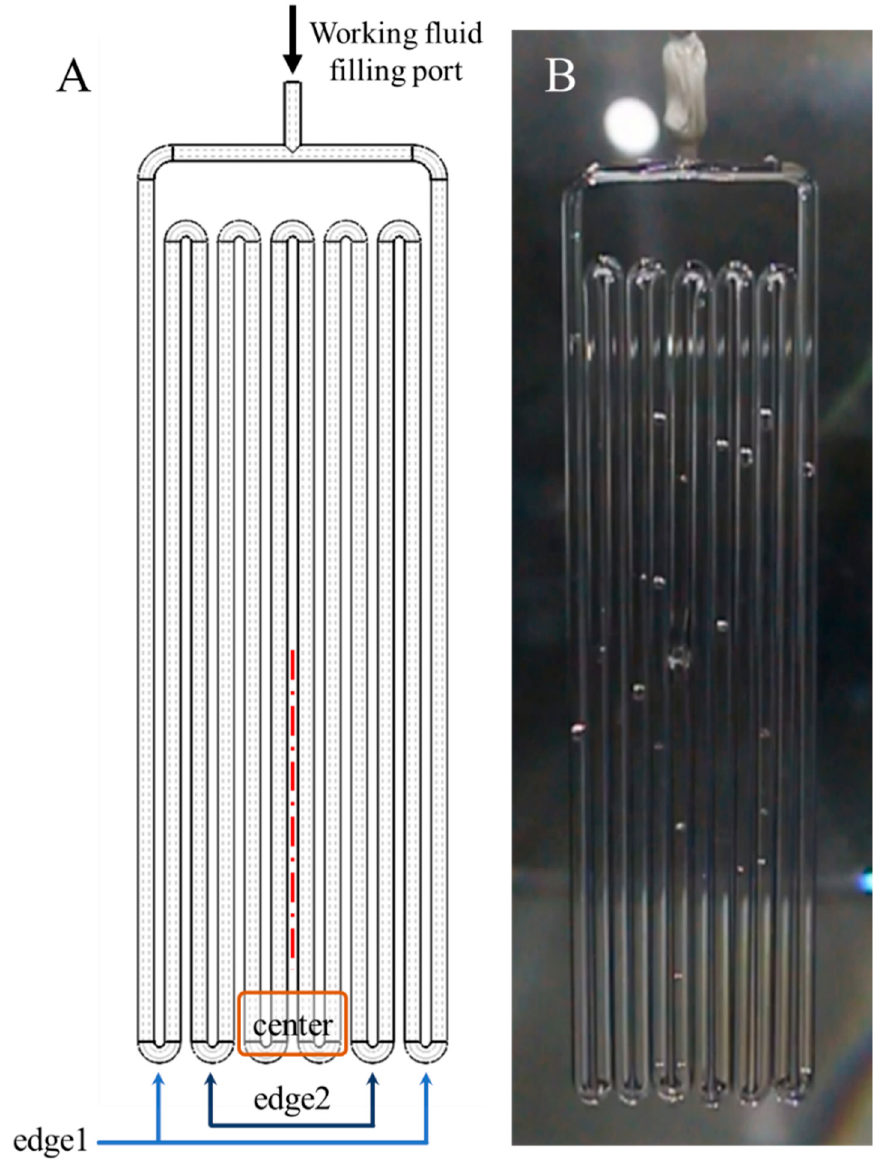
Figure 3. ( A ) Apparatus of PHP and temperature statistics group setting; ( B ) photograph of PHP.